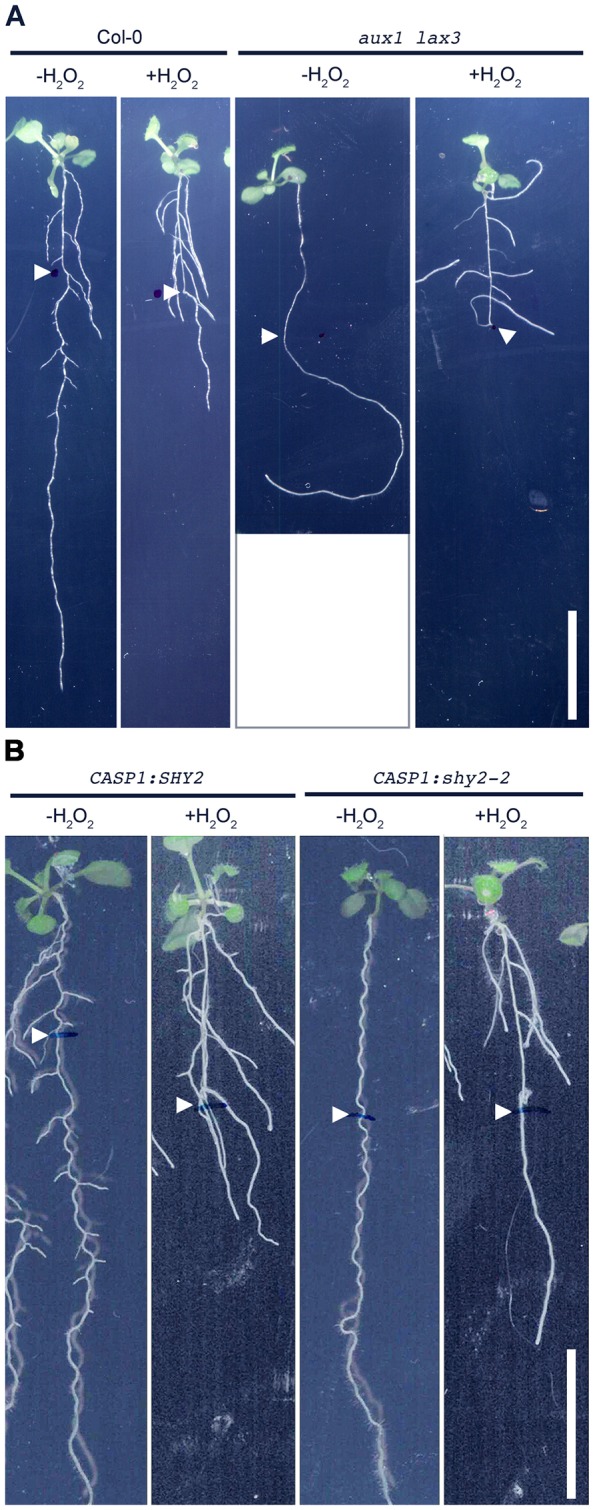
The effect of ROS on the LR phenotype of auxin mutants. (A) Effect of exogenous H2O2 on LR formation in Col-0 (control) and aux1 lax3 background. (B) Effect of exogenous H2O2 on LR formation in pCASP1:SHY2 (control) and in pCASP1:shy2-2 gain-of-function background. Five-day-old seedlings were exposed to H2O2 (1.5 mM) for 7 days. White arrowheads indicate the root tip region at the moment of transfer. Scale bars: 1 cm.